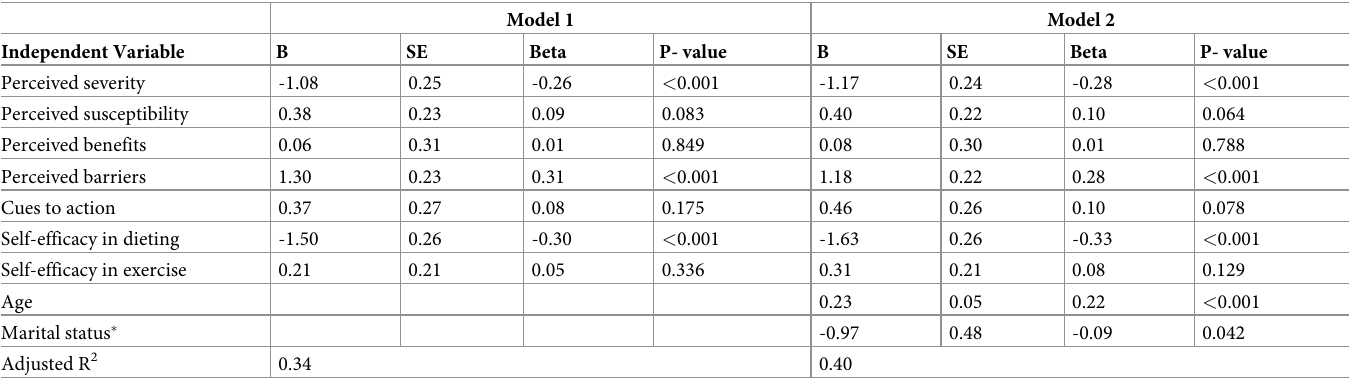
Table 4. Hierarchical multiple regression analysis for predicting body mass